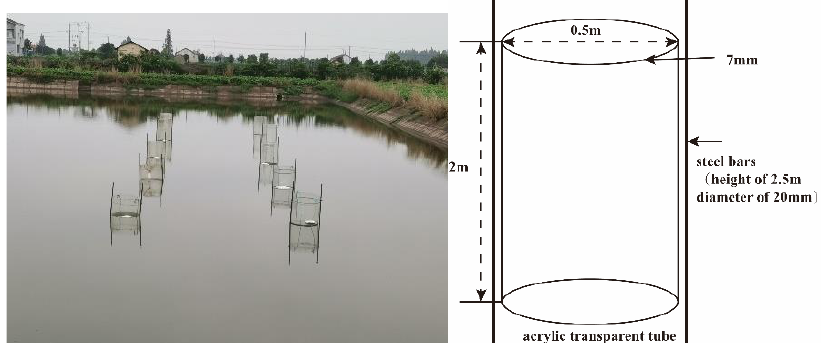
Figure 1. Acrylic transparent tubes erection straight view.